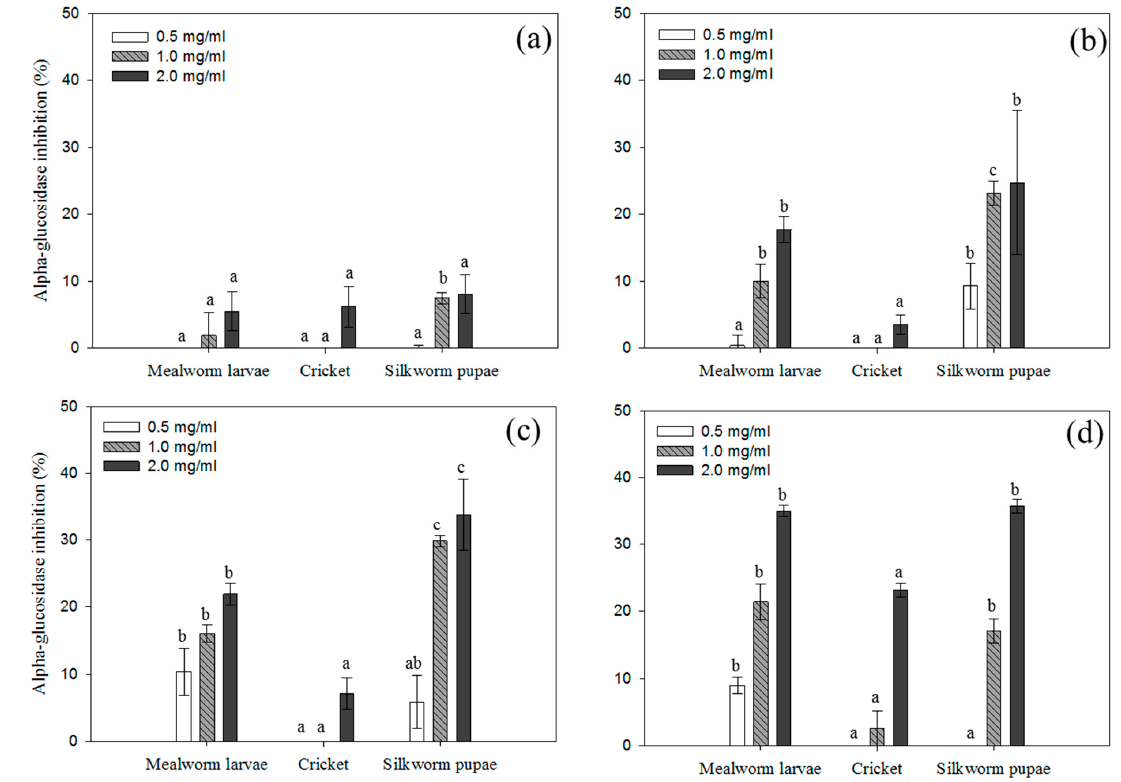
Figure 7. α -Glucosidase inhibitory activity of ( a ) insect proteins and their hydrolysates following treatment with ( b ) Flavourzyme, ( c ) Alcalase, and ( d ) a mixture of Flavourzyme and Alcalase. Each value is expressed as the mean ± SD ( n = 3); different letters indicate significant differences among treated groups ( p < 0.05).